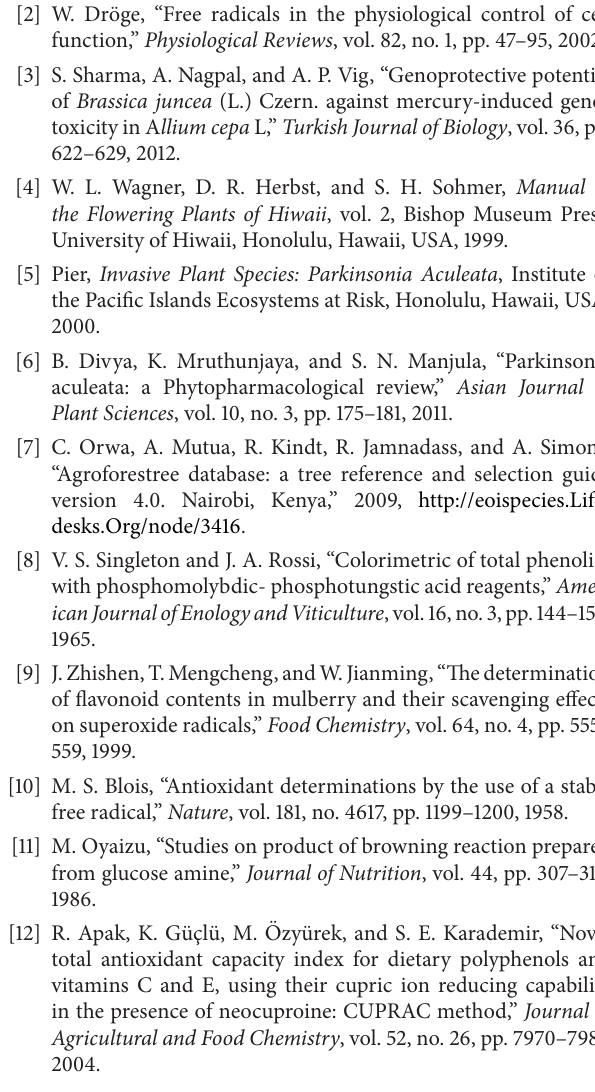
like gallic acid, catechin, chlorogenic acid, caffeic acid, ellagic acid, tert-Butylhydroquinone, and so forth. Gupta et al. [26] also observed pharmacognostic characters which